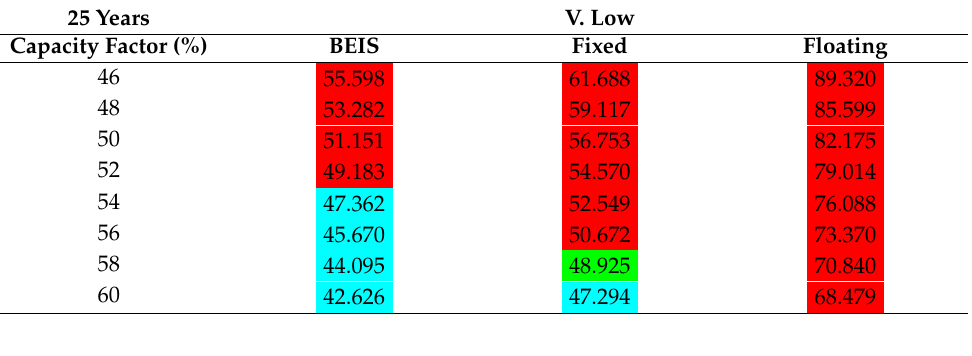
Table 12. Net Capacity (20 Years).